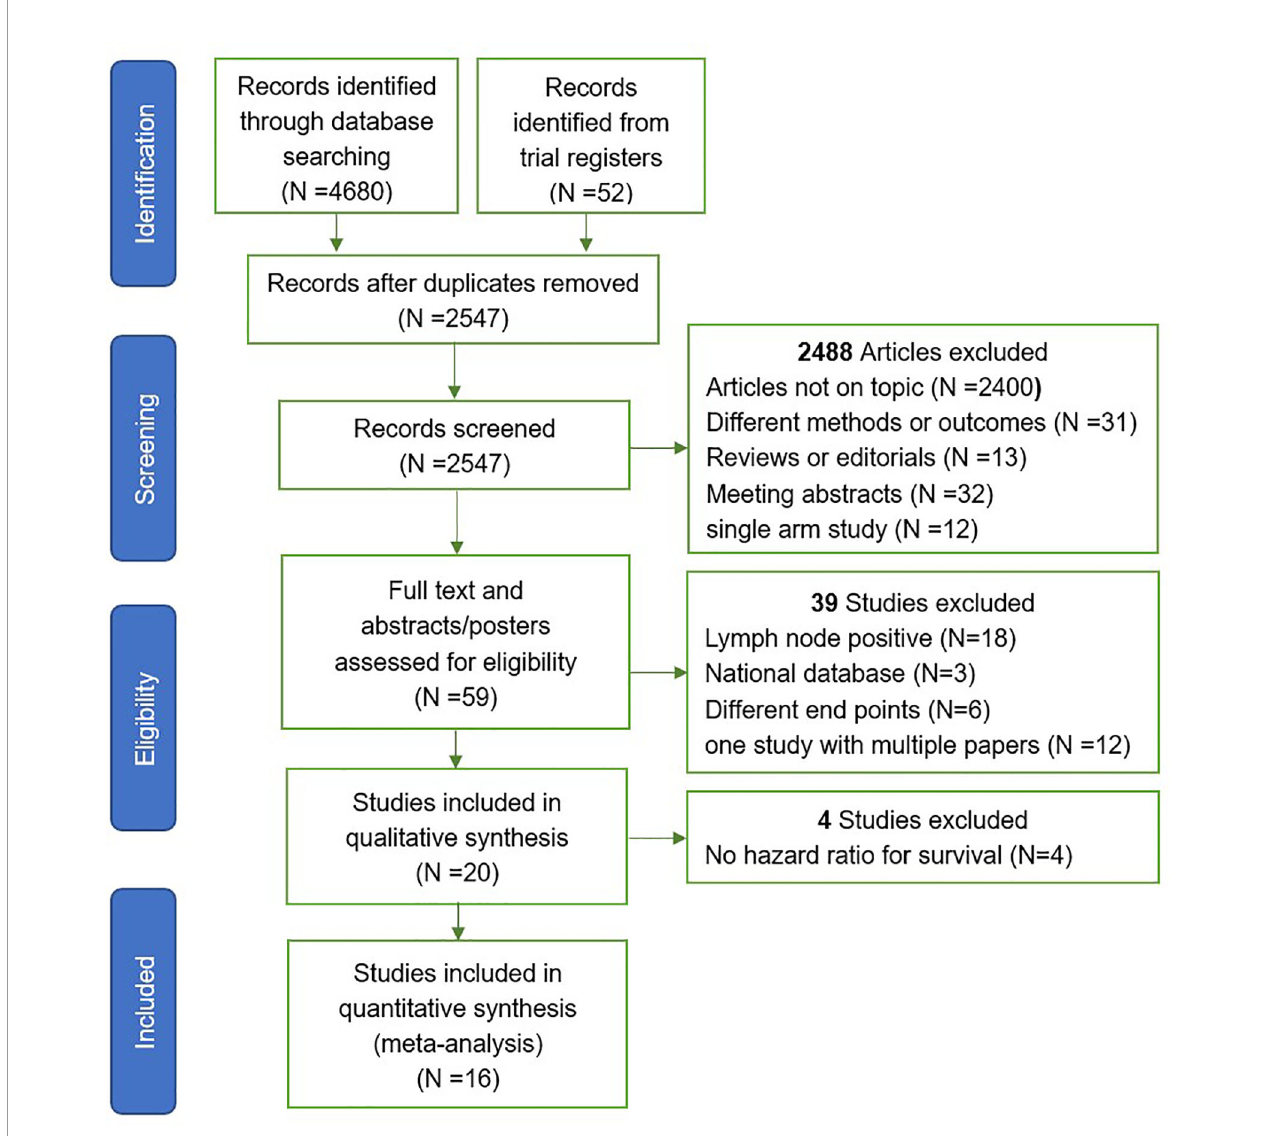
FIGURE 1 | Study selection. Flowchart of trials included and excluded from